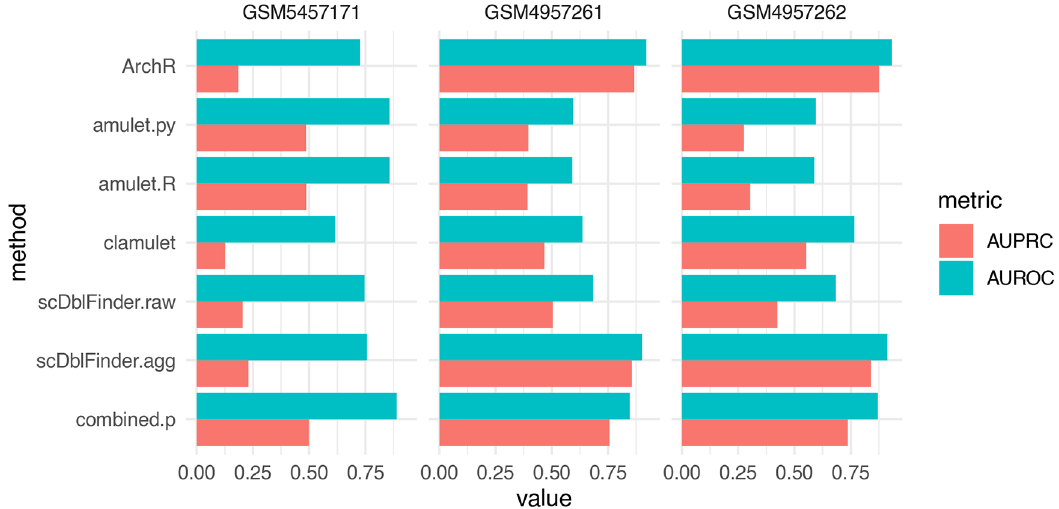
Figure 7. Doublet identification in three single-nucleus ATAC-seq datasets. ‘ amulet.py ’ and ‘ amulet. R ’ respec- tively stand for the original and R reimplementation of the method. ‘ scDblFinder.agg ’ stands for the feature aggregation approach. ‘ combination ’ indicates a Fisher combination of the amulet. R p-value and the 1 minus the scDblFinder.agg score. For ‘ ArchR, ’ the DoubletEnrichment output was